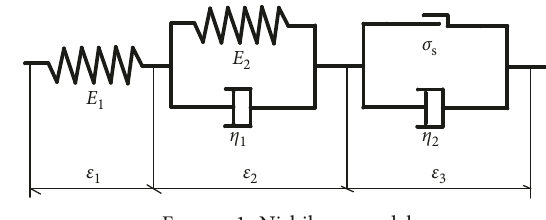
Figure 1: Nishihara model.